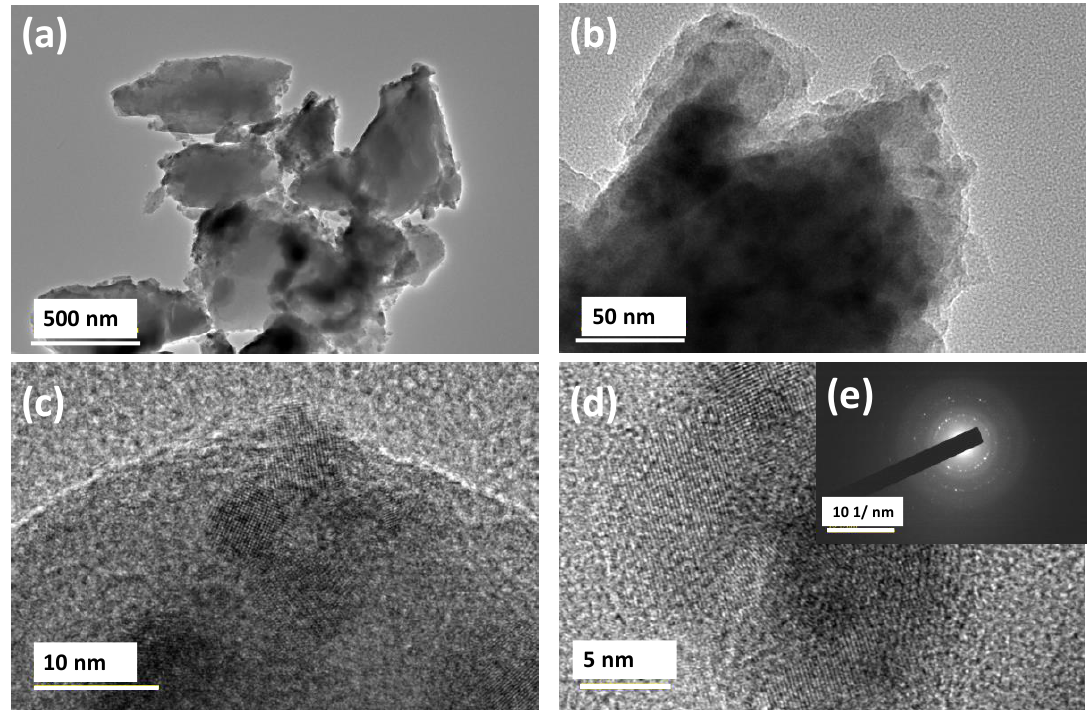
Figure 5. PLD at 500 °C transmission electron microscope images at various magnification ( a – d ) along with the corresponding selected area diffraction pattern (insert) from image ( e ).